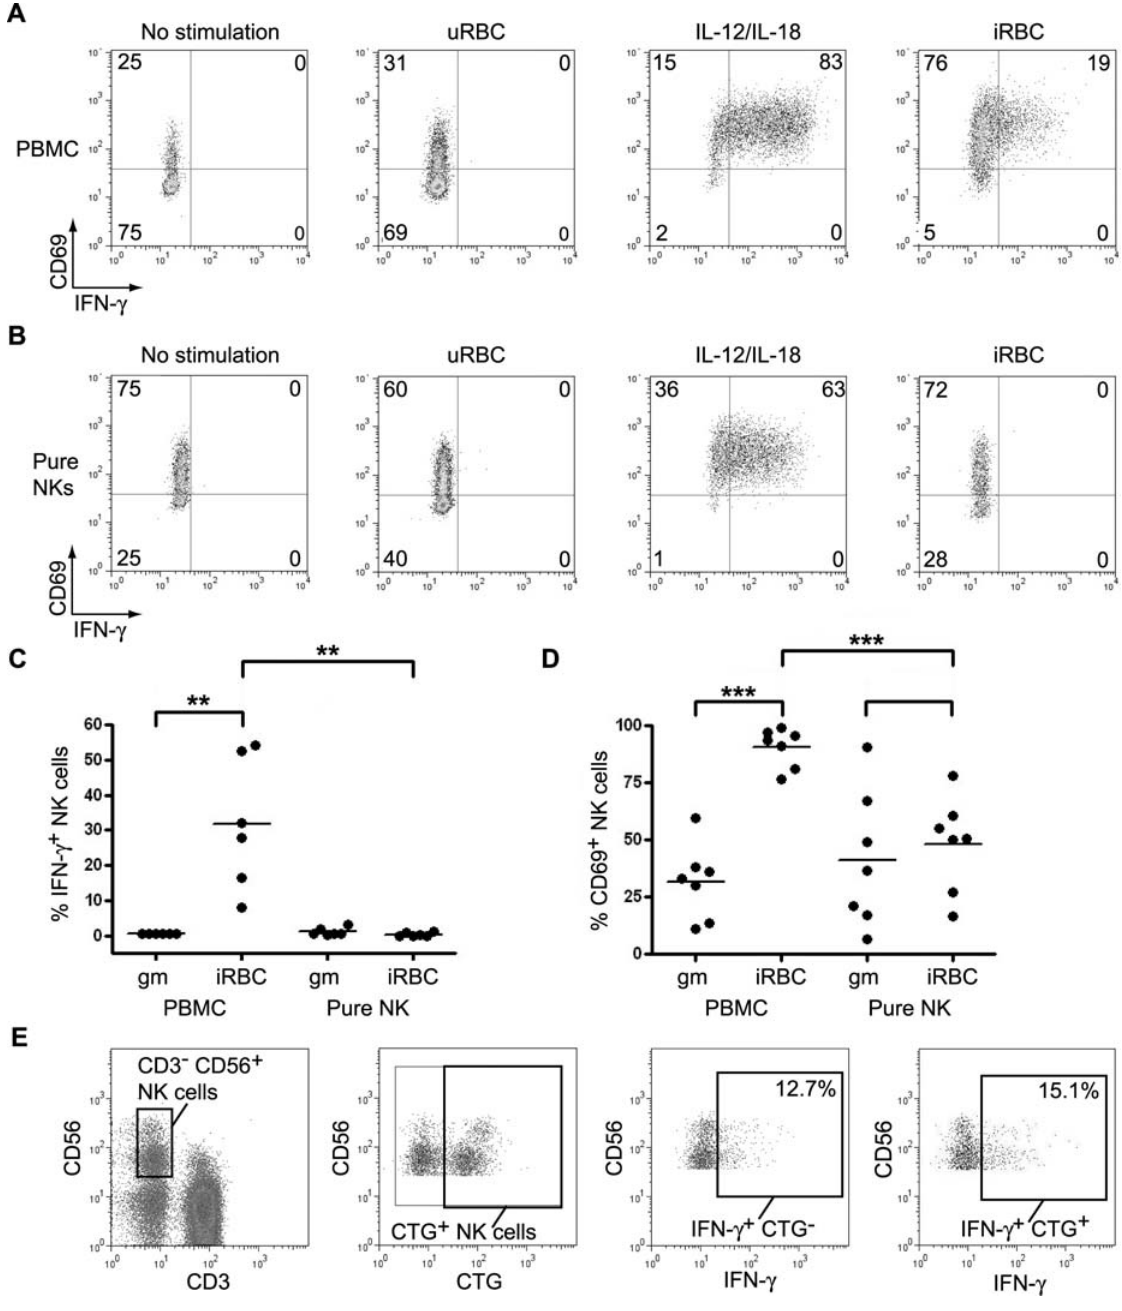
Figure 1. NK Cells Do Not Respond to iRBCs in the Absence of Accessory Cells PBMCs or MACS-purified NK cells from malaria-naı¨ve donors were cultured alone or with IL-12 and IL-18, uRBCs, or live iRBCs for 24 h. Intracellular IFN- c and surface expression of CD69 on CD3 (cid:1) CD56 þ NK cells were analysed by flow cytometry. (A and B) Representative example of NK responses to uRBCs, IL-12 and IL-18, and iRBCs in PBMCs (A) and purified NK cells (B). FACS plots are gated on CD3 (cid:1) CD56 þ lymphocytes. Percentages indicate the proportion of CD3 (cid:1) CD56 þ NK cells in each gate; data are based on the collection of 100,000 total events. (C and D) Comparison of NK responses to iRBCs in PBMCs and in purified NK cells. (C) NK cell IFN- c production for six donors. (D) CD69 surface expression levels for seven donors. **, p , 0.01; ***, p , 0.001; p -values are for paired t tests comparing stimulated and unstimulated NK cells from the same donor, or PBMCs and pure NK cells from the same donor. (E) MACS-purified, CTG-labelled NK cells were added to autologous PBMCs. IFN- c production in CTG þ (MACS-purified) and CTG (cid:1) ( ‘‘ untouched ’’ ) NK cells was assessed by flow cytometry after 24 h of stimulation with iRBCs. A representative example of the software gating strategy to analyse IFN- c responses of CTG-labelled NK cells is shown. FACS plots were gated on CD3 (cid:1) CD56 þ NK cells within the lymphocyte population (first panel), and NK cells were analysed for CTG staining (second panel). CTG þ CD3 (cid:1) CD56 þ NK cells (third panel) or CTG (cid:1) CD3 (cid:1) CD56 þ NK cells (fourth panel) were selected and analysed for intracellular IFN- c production. Numbers indicate the proportion of IFN- c þ NK